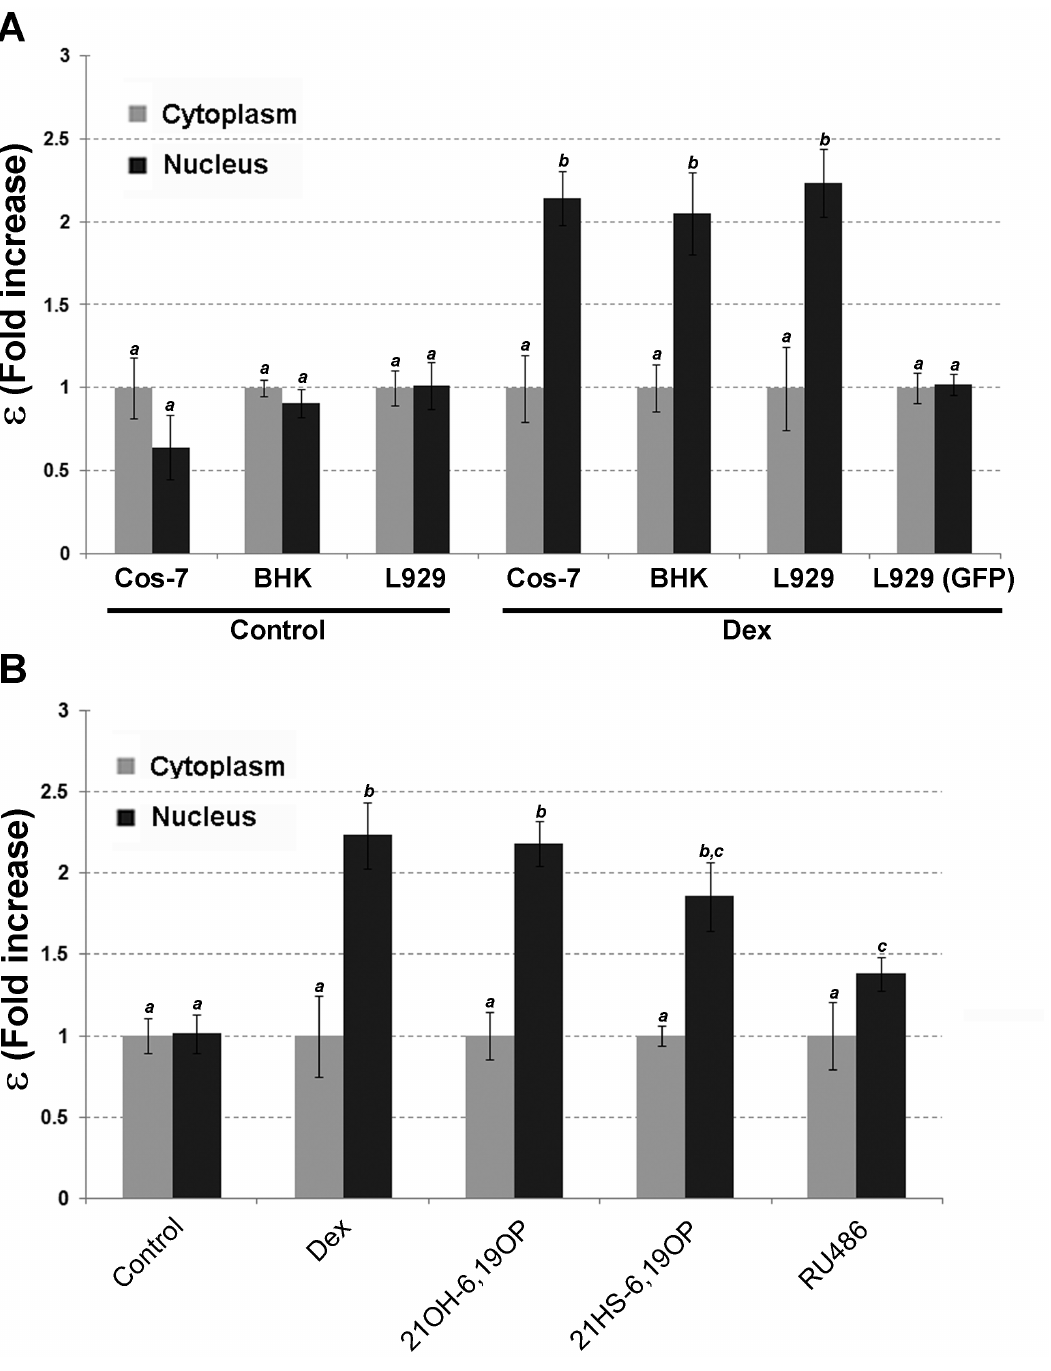
Figure 3. Invivo oligomerization analysis of GFPGR molecules. A . Cos-7, BHK21, and L929 cells transfected with pGFPGR were incubated with ethanol (Control) or 10 nM Dex for at least 40 min at 37 C. L929 (GFP) indicates cells tranfected with pEGFP and incubated with 10 nM Dex. B . L929 cells transfected with pEGFPGR were incubated with ethanol (Control), 10 nM Dex, 10 m M 21OH-6,19OP, 10 m M 21HS-6,19OP or with 1 m M RU486 for at least 40 min at 37 C. Images were taken between 40 min-6 h after steroids addition. For each cell (15 # n # 30 per treatment) the apparent brightness was calculated as described in ‘‘Materials and Methods’’. The figure shows fold-increase of the real brightness ( e ) relative to the cytoplasm for each cell type. Bars with different superscript letters are significantly different from each other ( P , 0.05). ligand is bound to the receptor. Moreover, results also imply that 21OH-6,19OP antagonistic effect on gene expression activation would not be related to the ability of the GR LBD-21OH-6,19OP complex to form homodimers in the nucleus.